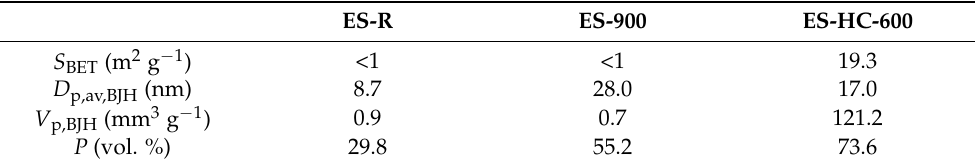
Figure 5. Scanning electron microscope (SEM) micrographs of raw materials and products during catalyst synthesis: (a) ES- R, (b) ES-900, and (c) ES-HC-600. Table 1. Texture properties obtained by Hg-porosimetry and N 2 -physisorption. Table 1. Texture properties obtained by Hg-porosimetry and N 2 -physisorption.